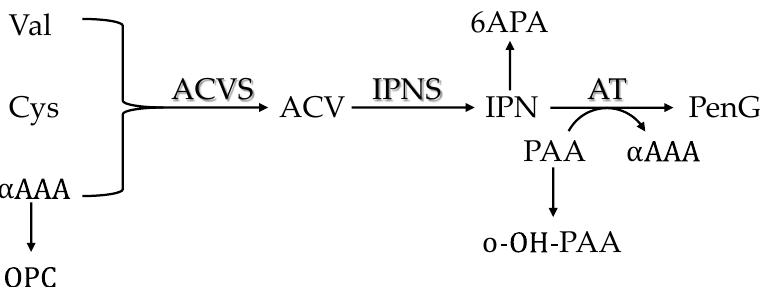
Figure 6. A schematic view of the penicillin biosynthesis pathway and the derived byproducts mentioned in this study. Precursors are L- α -amino adipic acid ( α AAA), L-cysteine (Cys) and L-valine (Val). ACVS: L- α -( δ -aminoadipyl)-L- α -cysteinyl-D- α -valine synthase; IPNS: isopenicillin N synthase; AT: acyl-CoA:isopenicillin